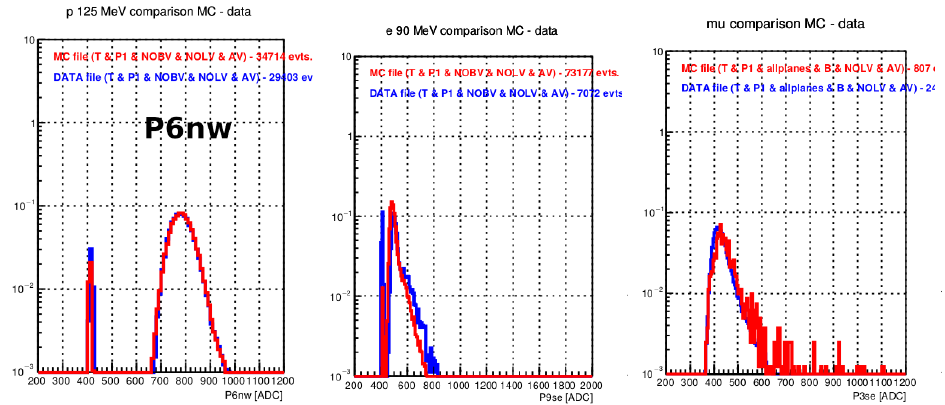
Figure 5. Comparison between distributions of real (blue) and reconstructed ADC signal from MC (red) for 3 PMTs for 125 MeV protons (left), 90 MeV electrons (center) and muons (right). Selections used are the same for the two distributions and are: most significant paddle & P1, no hit in any veto and trigger multiplicity equal to